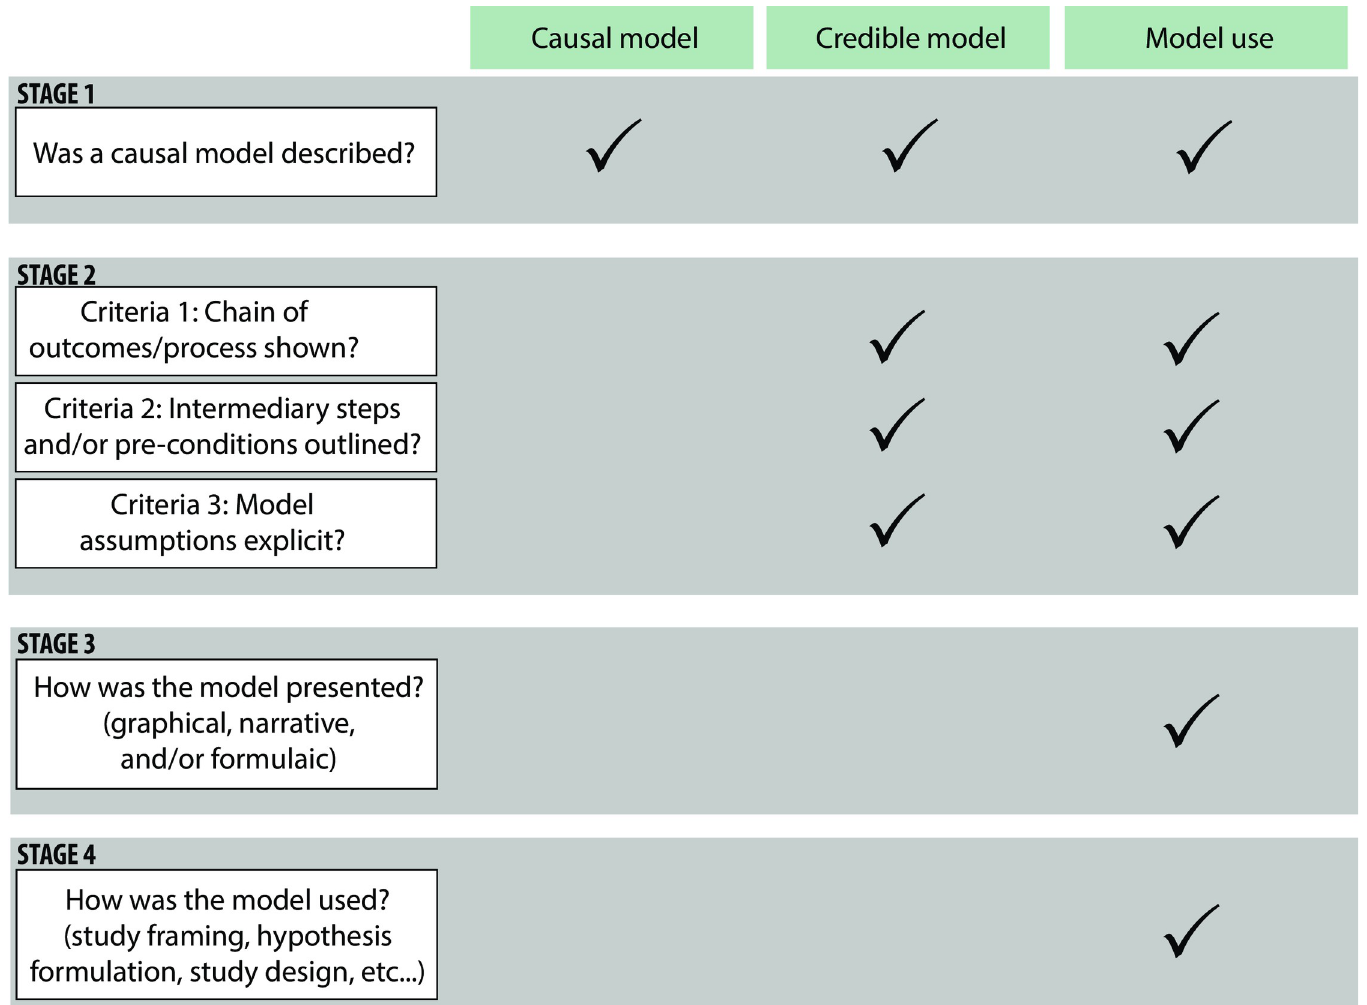
Fig 1. Coding scheme for assessing causal models, credible causal models, and